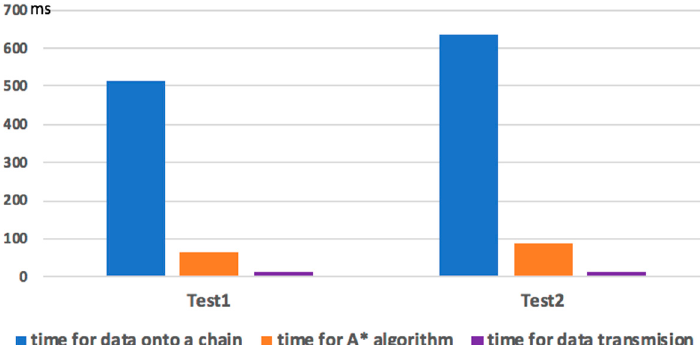
Figure 12. Comparisons of service response time (milliseconds).